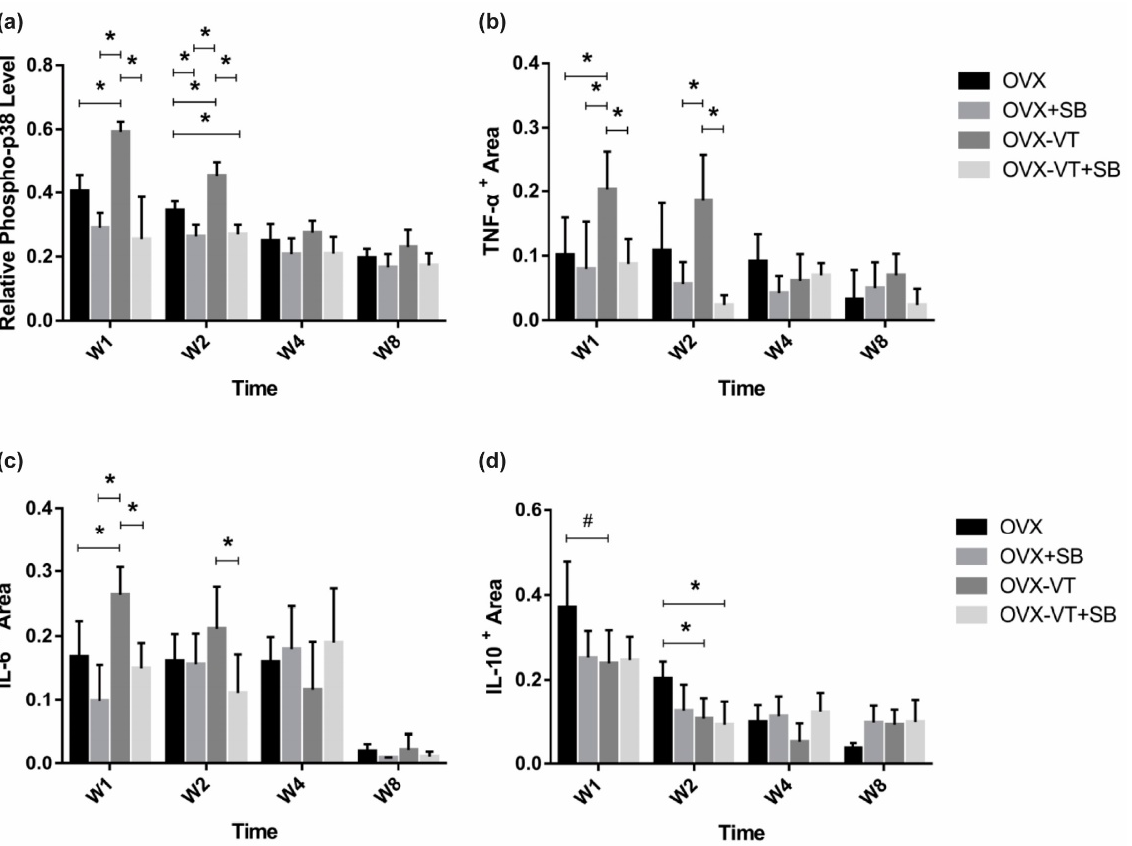
Figure 1. Immunohistochemistry results. Relative expression of major inflammatory cytokines were quantified by immuno- histochemistry at the fracture callus. ( a ) Relative pp-38 was found to be significantly increased by VT in OVX animals, and the inhibition of p38 removed the VT treatment effect in week 1 post fracture; ( b ) pro-inflammatory TNF- α showed a similar pattern of expression; ( c ) as well as the pro-inflammatory cytokine IL-6, ( d ) the anti-inflammatory cytokine IL-10 showed decreased expression after the SB, VT, and VT+SB treatment at weeks 1 and 2. * Statistical significance considered at p < 0.05, # approaching significance at p = 0.064, one-way ANOVA with post-hoc Bonferroni test. Abbreviation: W: week.